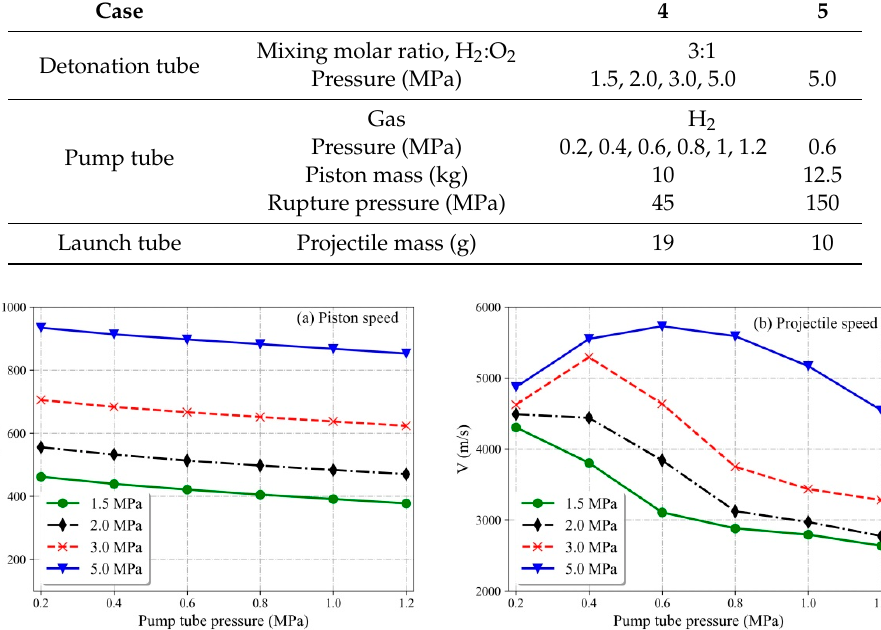
Figure 13. Simulated results at different detonation pressures. ( a ) maximum piston speed versus the initial pump pressure; ( b ) muzzle projectile speed versus the initial pump pressure.